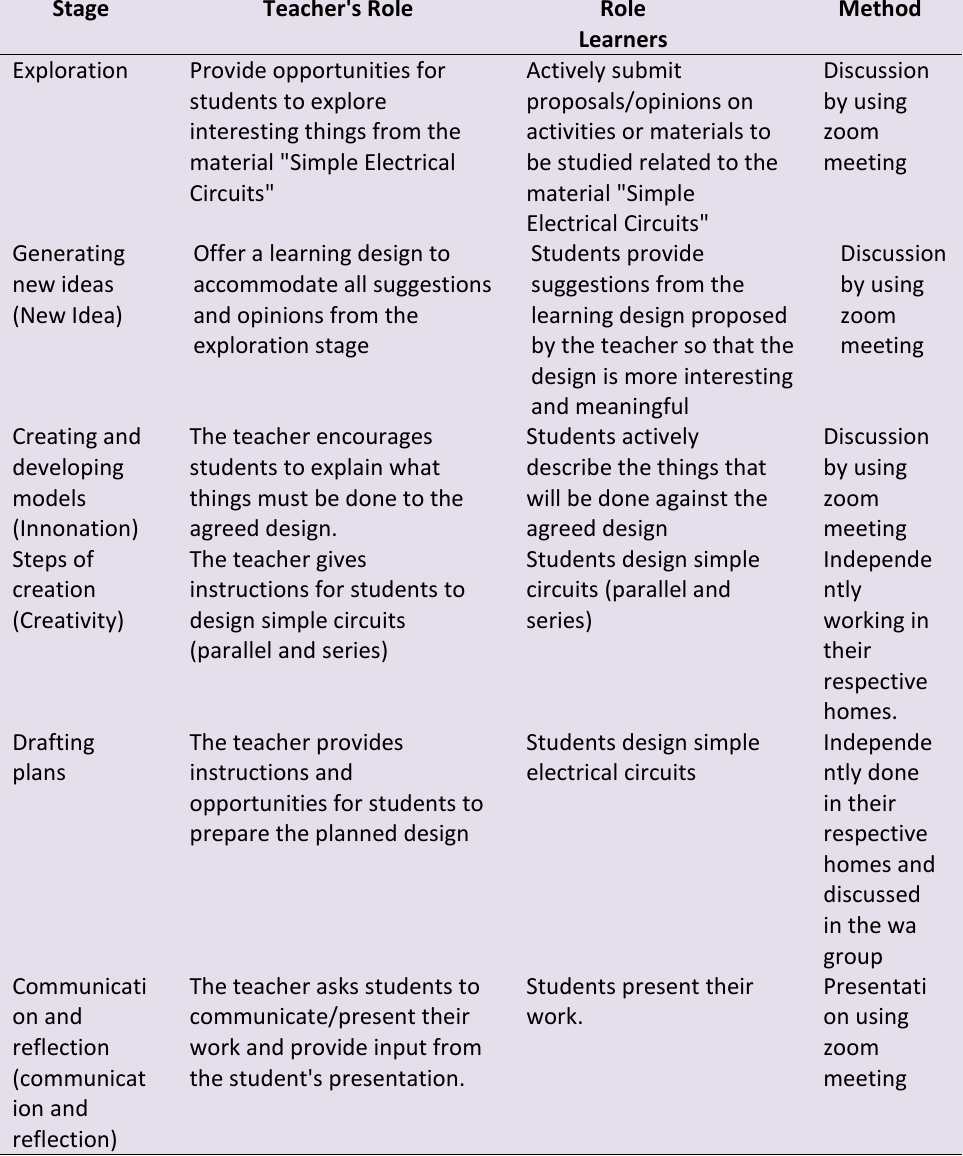
Table 1 . Indicators of Learning Management by Implementing